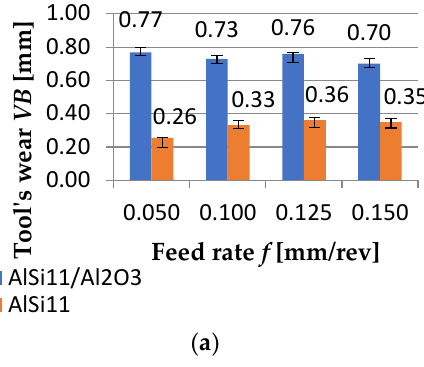
Figure 11. Results of measurements of tool ’ s wear: ( a ) for FEPA 046 and ( b ) FEPA 100 compared to AlSi 11 (exact values are given above the bars).